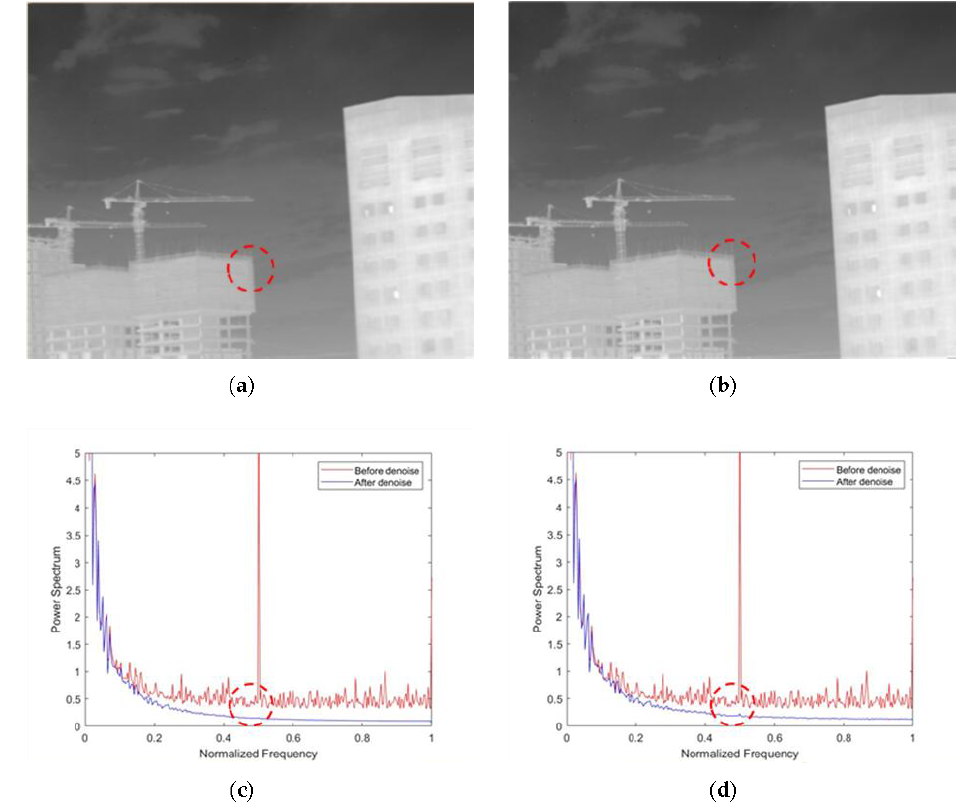
Figure 10. Denoising effects of ablation experiment on an image of complex buildings: ( a ) non-AEPO; ( b ) our approach; ( c ) non-AEPO; ( d ) our